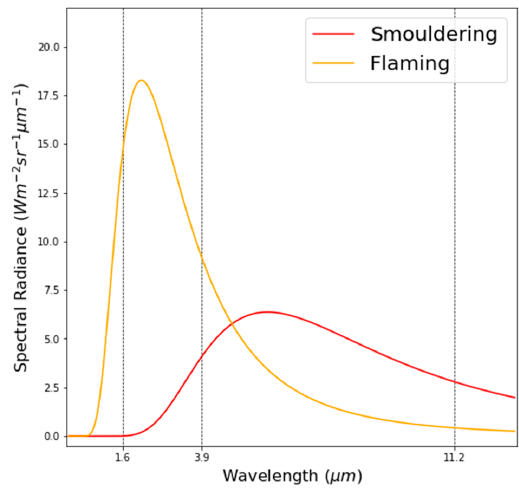
Figure A6. Planck curves for blackbodies at temperatures typical for flaming and smouldering combustion.